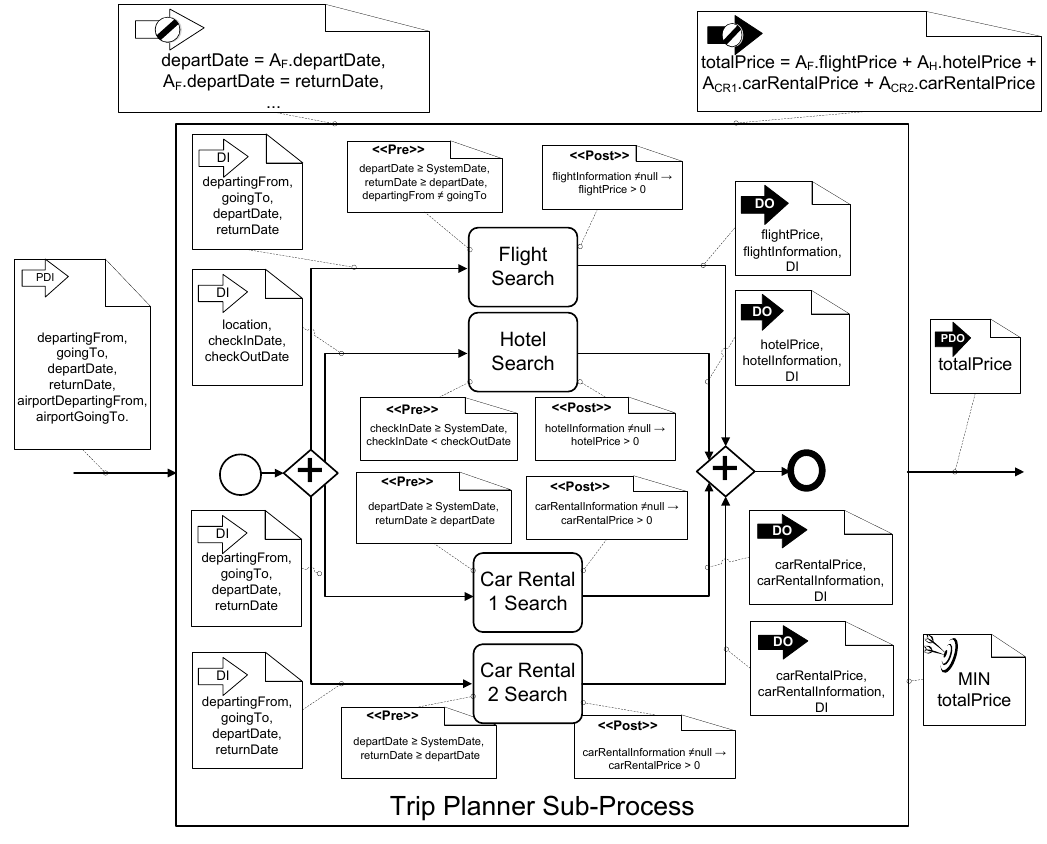
Figure 3. Example of Trip Planner Formalization using DOOPT-DEC